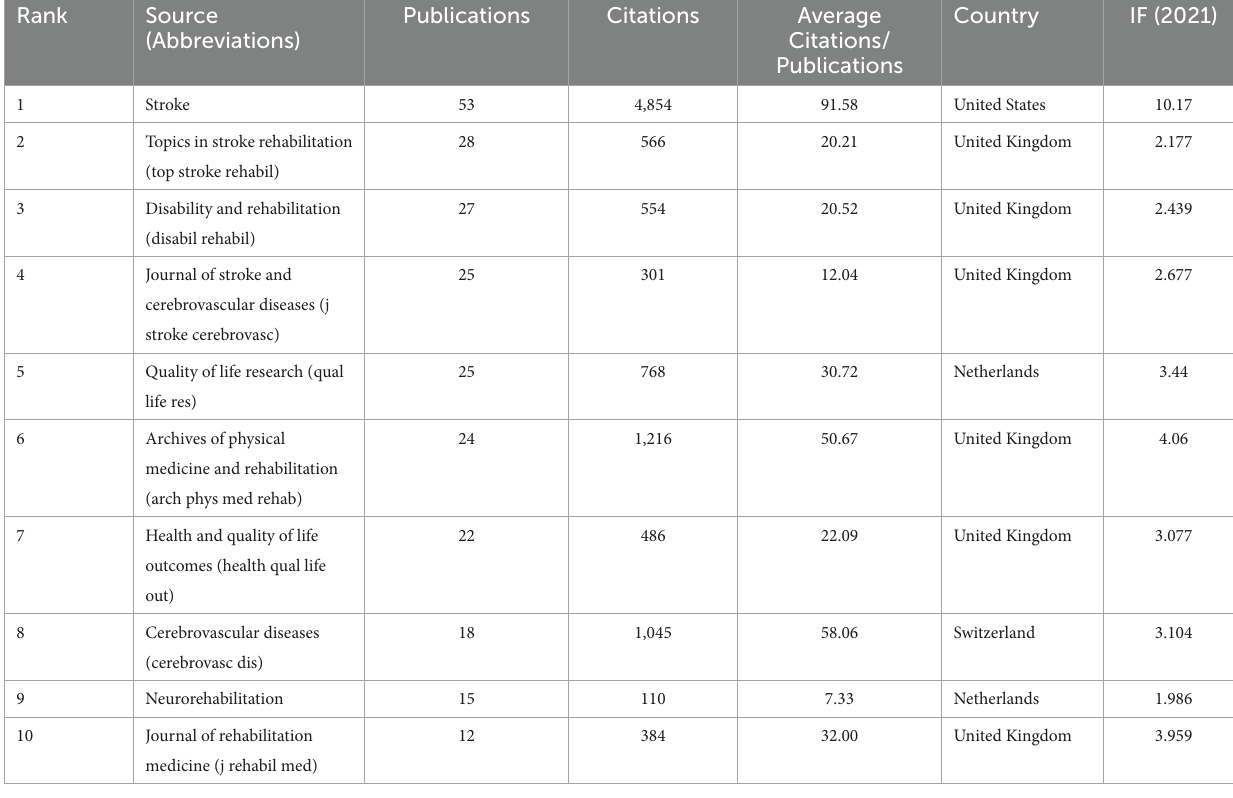
TABLE 2 Top 10 academic journals based on publications.